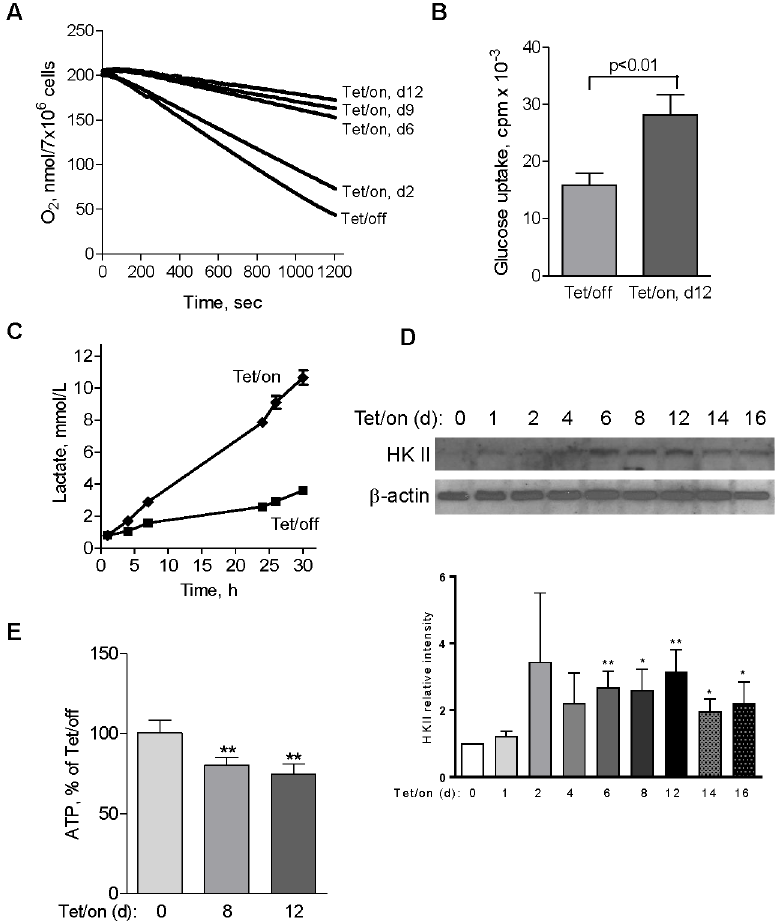
Fig 2. Suppression of mitochondrial respiration by POLGdn expression led to an elevation of glycolysis. (A) Time-dependent decreasein cellularoxygen consumptionfollowingPOLGdn expression. Reductionof oxygen consumption was observedas early as 2 d after POLGdn expression, and the cells dramatically decreased their ability to consume oxygen with prolongedPOLGdn expression. (B) Increased glucoseuptake in POLGdn-expressing cells (Tet/on, d12). Cells (2 × 10 6 ) were incubatedin 5 ml glucose-free RPMI1640 medium for 2 h, followedby incubationwith 0.2 μ Ci/mL 3 H-2-deoxyglucosefor 1 h. Cellularuptake of 3H-2-deoxyglucosewas determined by liquidscintillation countingafter the cells were washedtwo times with PBS. Error bars, ± SD. p < 0.01(n = 3). (C) Increasedlactate generationin Tet/on cells. Lactate in Tet/off and Tet/on (day 12) cells was measured at the indicatedtime points after changingto fresh culture medium. (D) Increasedprotein level of hexokinaseII (HKII) followingPOLGdn expression. Upper panels show representative HKII protein by Western blotting assay at the indicateddays after POLGdn inductionby doxycycline. Lower panels show quantification of Western blot results using scanningand ImageJ software. Results are expressedas integratedopticaldensity. Each sample was normalized to β -actin content. Each bar representsthe mean ± SEM of three independentexperiments. * p < 0.05; ** p < 0.01.(E) Comparison of cellularATP levels in cells with or without POLGdn expression. CellularATP contents in Tet/on cells (days 8 and 12) were measured and compared with the Tet/off cells. Error bars, ± SD ( ** p < 0.01and n =